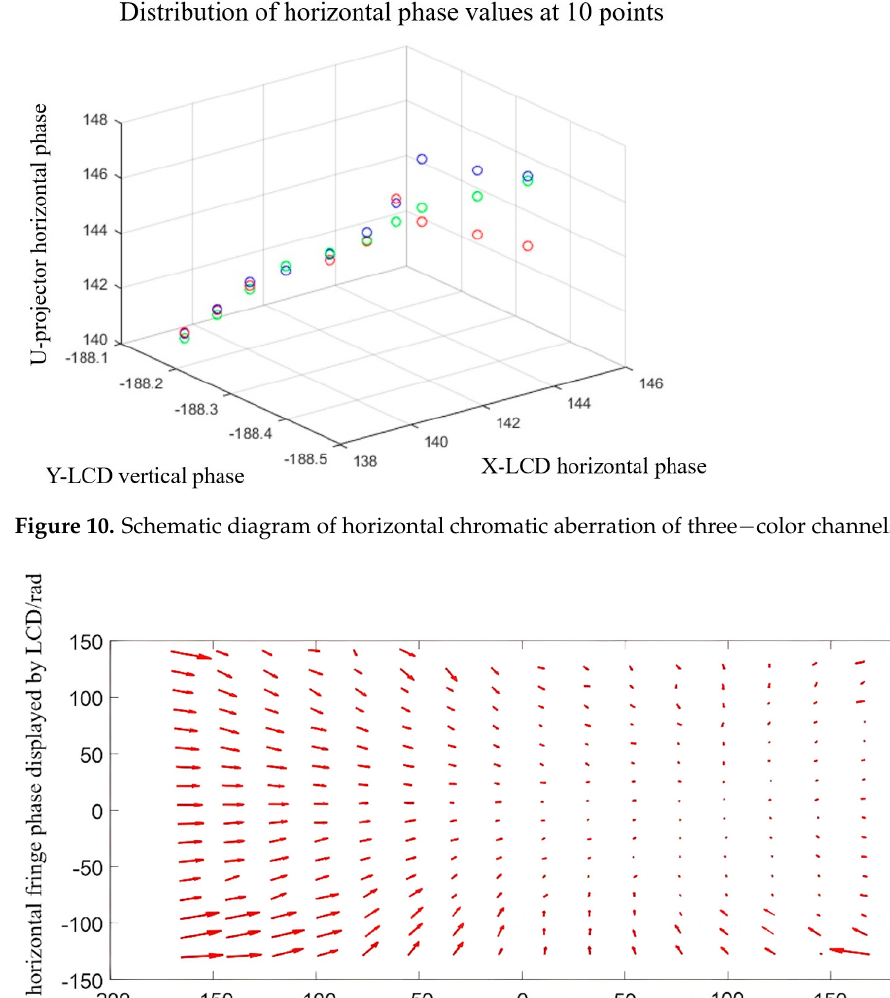
Sensors 2022 , 22 , x FOR PEER REVIEW